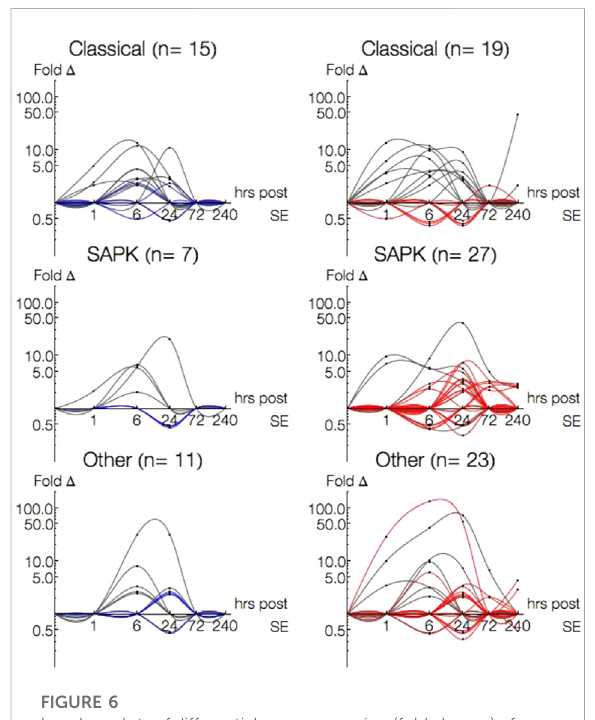
FIGURE 6 Log-Log plots ofdifferential geneexpression (foldchange) of single-pathway associated genes amongst Classical, SAPK and Other family groupings. Data points are indicated by black circles. Lines, each representing a single gene, were fi tted using second order interpolation for ease of visualization. Genes differentially expressed in both P15 (left column) and P30 (right column) are indicated in gray; Genes differentially expressed only in P15 are blue and only in P30 are red.